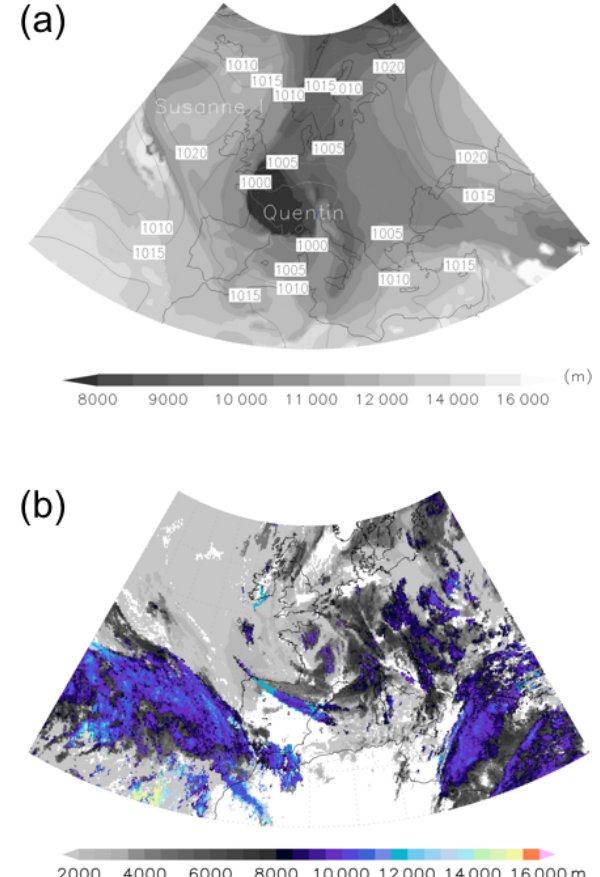
Figure 20. Panel (a) : mean sea level pressure (contours) and tropopause height (shaded contours) over Europe from GFS analy- ses on 21 November 2013 at 12:00UTC. Panel (b) : cloud top height from MSG data on 21 November 2013 at